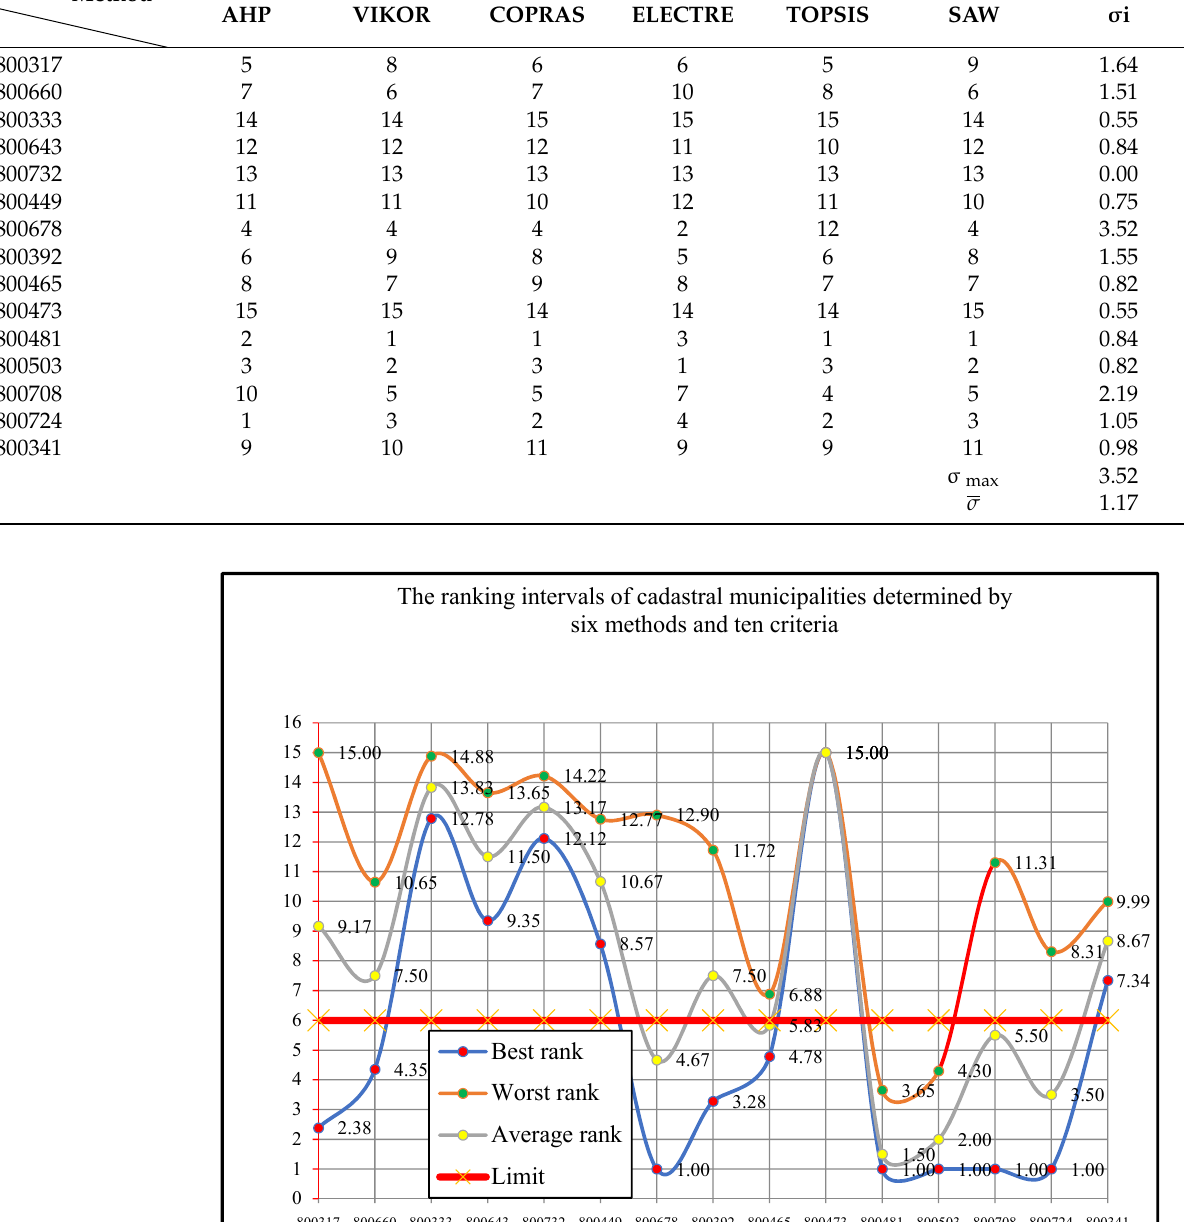
Figure 1. The ranking interval of cadastral municipalities with ten criteria.